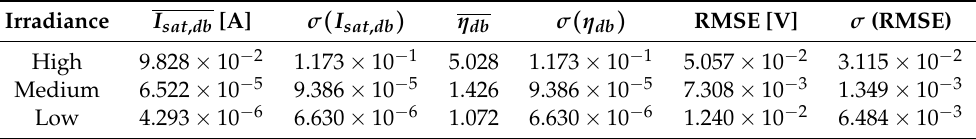
Figure 14. Left : Experimental (dots) and reproduced (line) I-V curve of the bypass diode in submodule 1 for medium irradiance level. Right : percentage errors of the bypass diode voltage. Table 6. Estimated parameters for bypass diode in submodule 1 for high, medium and low irradiances from experimental data and RMSE in the I-V curve